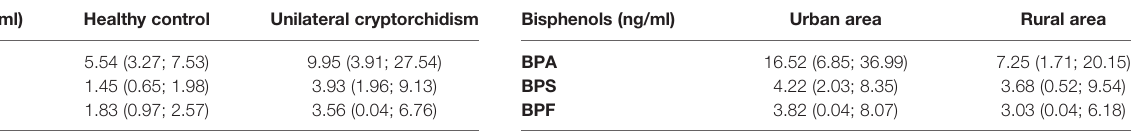
TABLE 1 | Bisphenols plasma levels in the healthy control and unilateral cryptorchidism group a . Bisphenols (ng/ml)